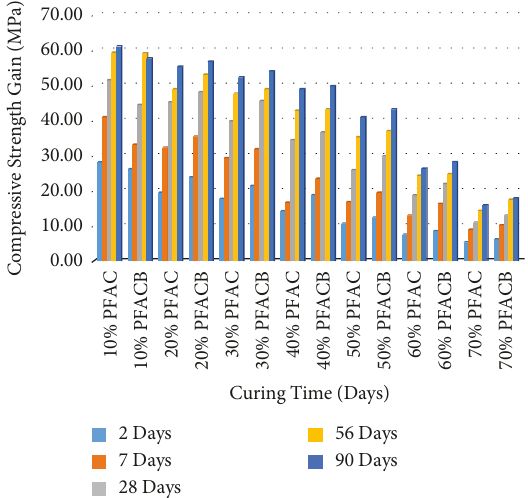
Figure 4: Compressive strength development for OPC substituted with PFA (w/c (cid:30)